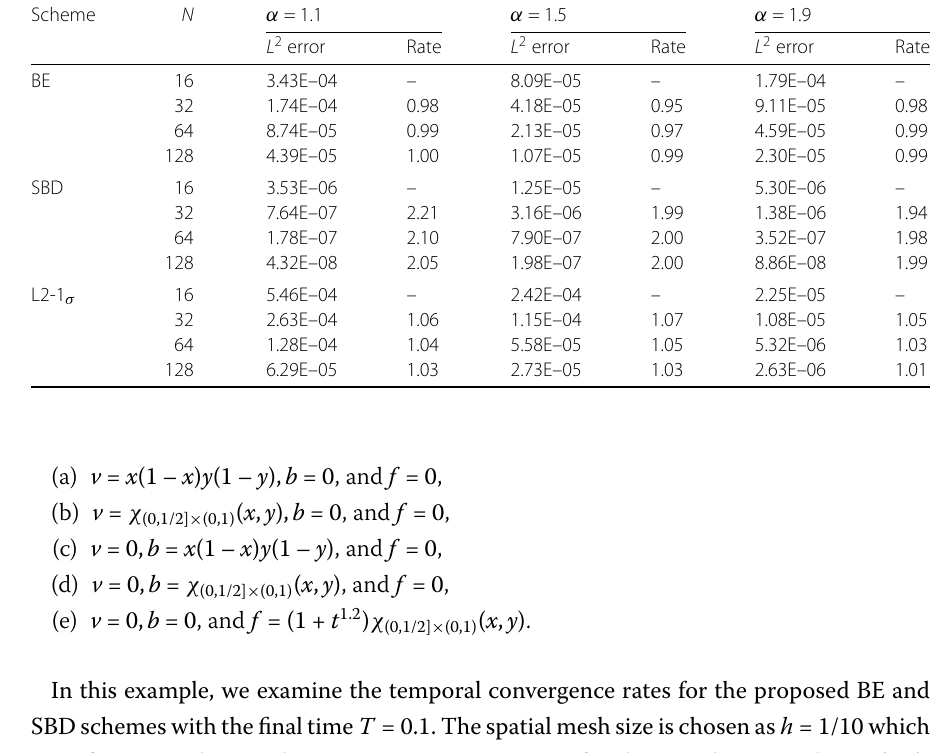
Table 3 The L 2 norm errors in time for case (a) in Example 6.2 with h = 1/10 Scheme